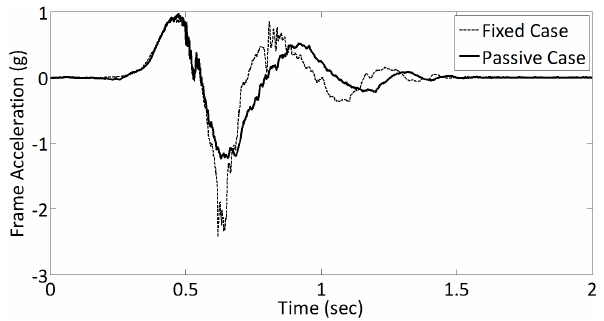
Figure 7. Drop Test: Car Body Acceleration.